Question: Give a one-sentence summary of this figure.
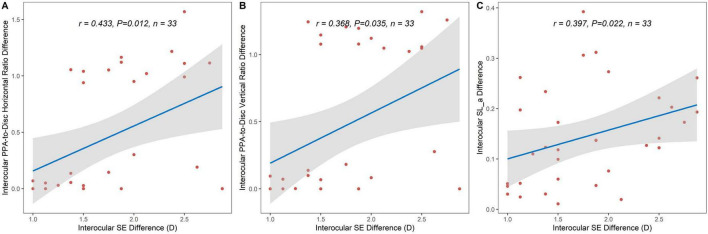
Answer: Scatter plots showing correlations between interocular differences in spherical equivalent (SE) and retinal parameters. (A) Horizontal diameter ratio of the PPA to the optic disc. (B) Vertical diameter ratio of the PPA to the optic disc. (C) :SL_a; Data points represent absolute interocular differences for each parameter, only correlations that reached statistical significance are presented; D, Diopter.